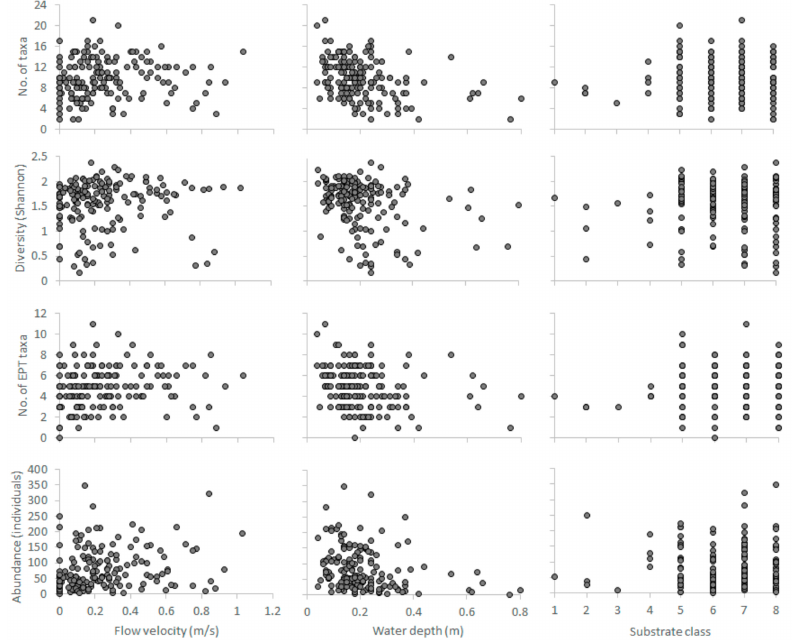
Figure A2. Hydroecological relationships developed from the summer samples ( n = 160) of the benthos-GR dataset between the three abiotic predictors and the four selected biotic response variables-metrics. Substrate classes; 1: Silt, 2: Sand, 3: Fine gravel, 4: Medium gravel, 5: Large gravel, 6: Small stones, 7: Large stones, 8: Boulders. EPT: Ephemeroptera, Plecoptera,